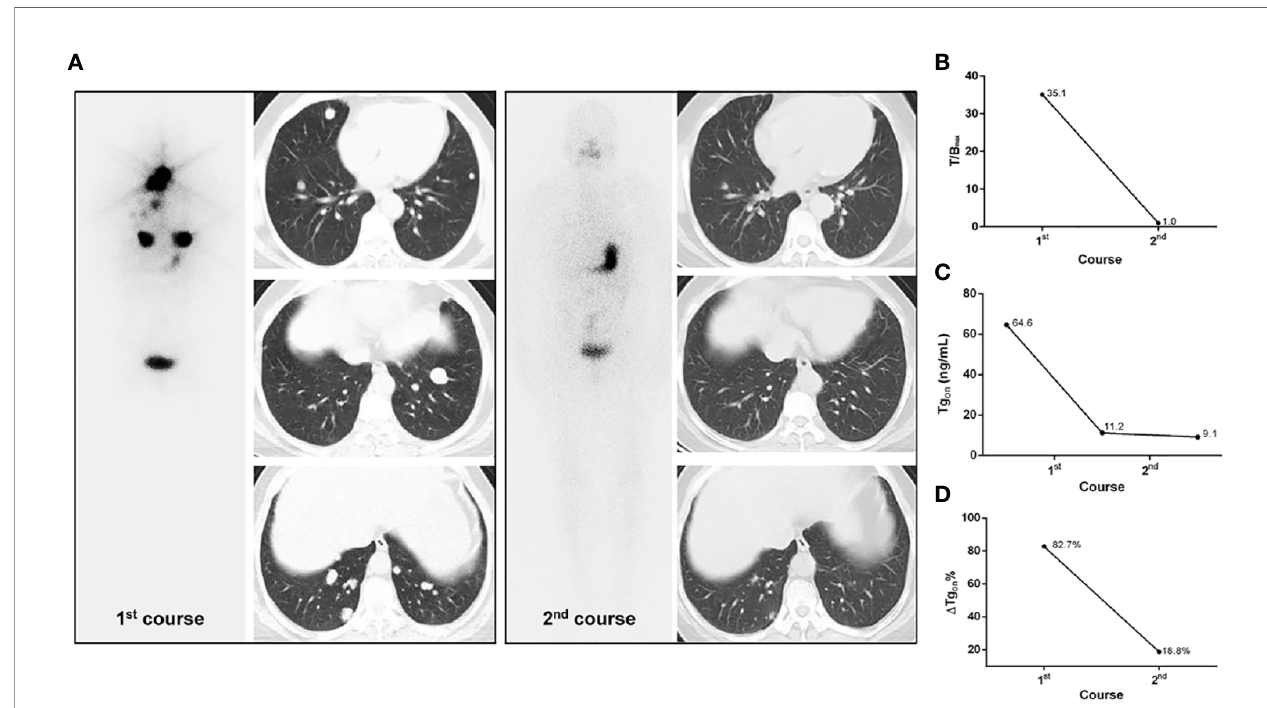
FIGURE 4 | A 53-year-old female differentiated thyroid cancer patient with robust 131 I-avid pulmonary metastases achieving excellent bene fi t from the initial RT. The T/B max and D Tg on % resulting from the initial course of RT were 35.1 and 82.7%, respectively. In the second course of RT, unexpectedly, post therapeutic whole body scans were negative and the size of lesions were dramatically decreased on chest computed tomography, along with a Tg on of 9.1 ng/ml, indicating an excellent bene fi t from the initial course of RT, which was demonstrated by a continuous decrease in Tg on to 0.9 ng/ml during the 3-year follow-up. (A) Whole body scans (anterior) at 3 days after the oral administration of 7.4 GBq of 131 I; (B) T/B max ; (C) Tg on ; (D) D Tg on %. RT, radioiodine treatment; T/B max , maximum target-to- background ratio; Tg on , thyroid stimulating hormone-suppressed thyroglobulin; D Tg on %, change rate of Tg on level.